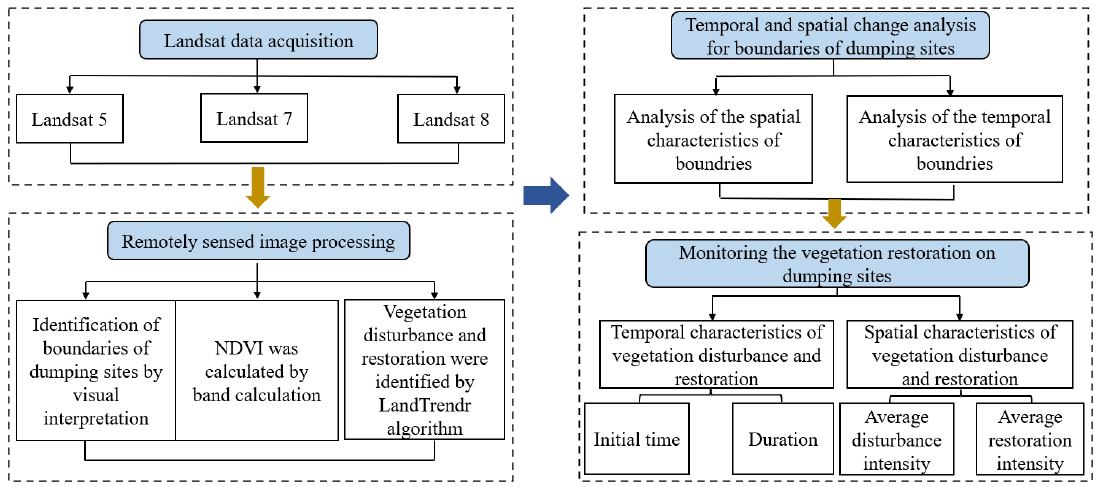
Figure 2. Process of monitoring and assessing the vegetation disturbance and